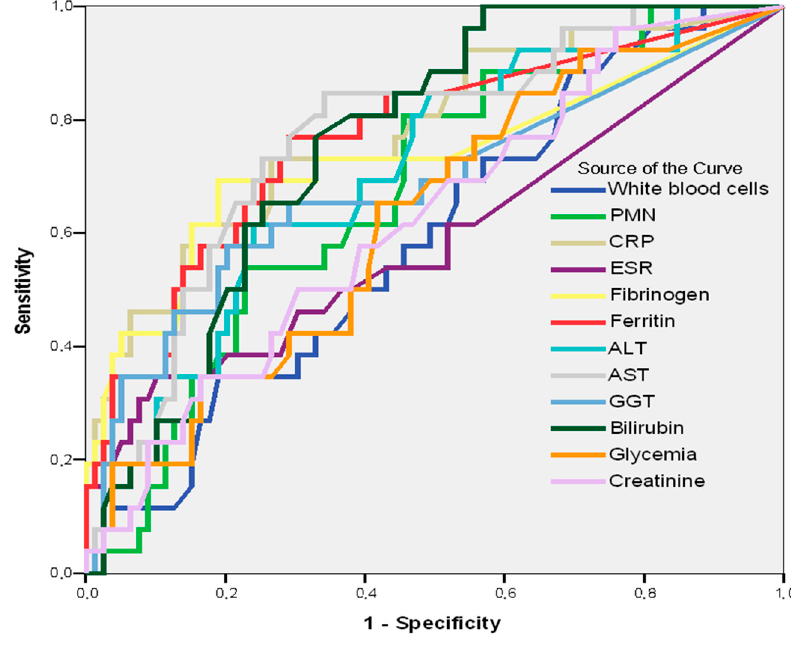
Figure 2. AUC. Laboratory parameter predictors of pneumonia in patients with SARS-CoV-2. By tracing the AUC, it is revealed that some hematological constants—CRP (AUC = 0.779; 95%CI: 0.672–0.886; p = 0.001), AST (AUC = 0.769; 95%CI: 0.668–0.871; p = 0.001), ferritin (AUC = 0.767; 95%CI: 0.657–0.877; p = 0.001), bilirubin (AUC = 0.758; 95%CI: 0.665– 0.851; p = 0.001), fibrinogen (AUC = 0.734; 95%CI: 0.605–0.863; p = 0.001), and ALT (AUC =